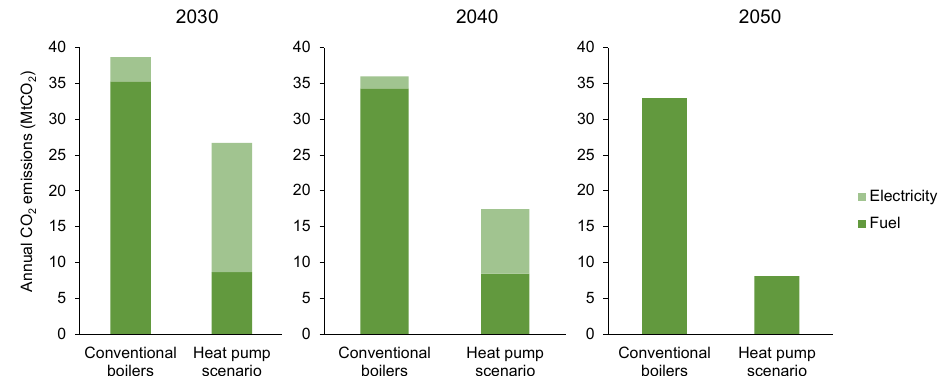
Figure 10. Annual CO 2 emissions from the textile wet-processing industry in China.